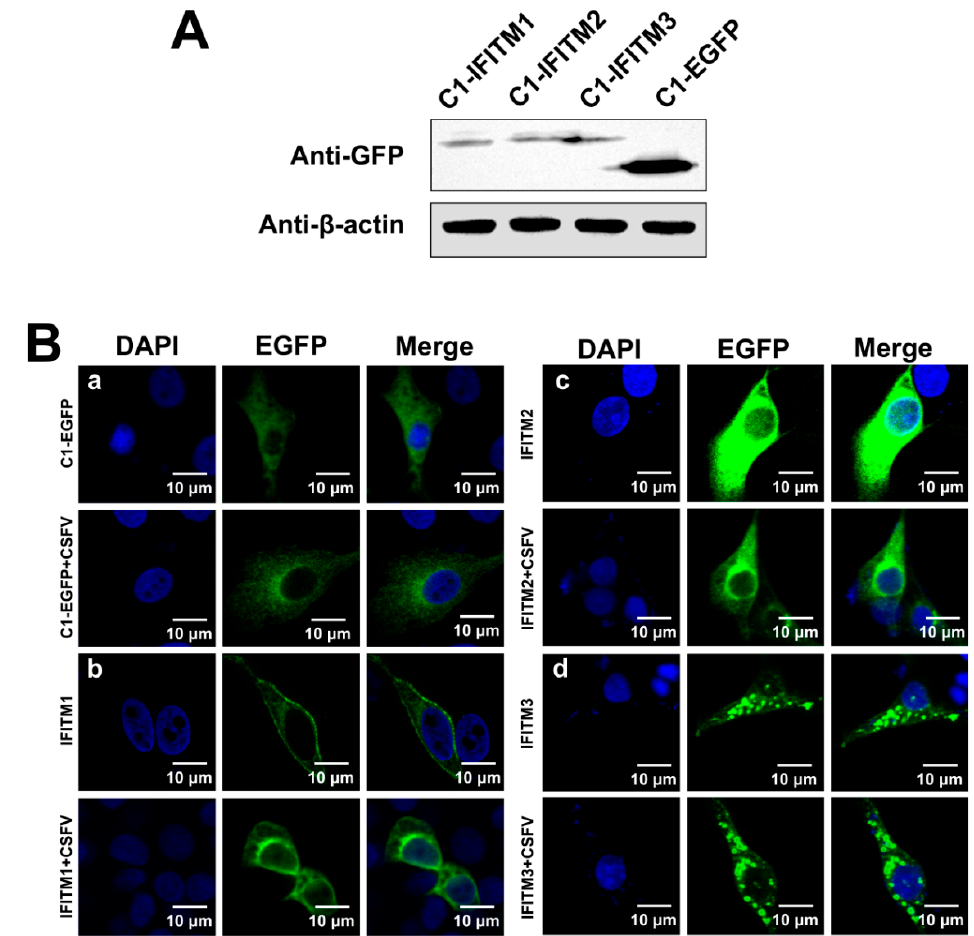
Figure 5. Distribution of IFITMs in CSFV-infected PAMs. ( A ) Confirmation of C1-IFITM1, C1-IFITM2, and C1-IFITM3 transfection in PAMs by western blot detection of fusion proteins with an anti-GFP antibody. PAMs were transfected with C1-IFITM1, C1-IFITM2, C1-IFITM3, or C1-EGFP for 48 h and collected for western blot analysis. β -actin served as an internal control. ( B ) Confocal images of PAMs expressing EGFP-tagged IFITM1, 2, or 3 or EGFP alone. PAMs were transfected with C1-EGFP ( a ), C1-IFITM1 ( b ), C1-IFITM2 ( c ), or C1-IFITM3 ( d ) for 24 h, followed by mock infection or infection with CSFV (MOI = 1) for another 24 h. Cells were fixed and stained with 4 (cid:48) ,6-diamidino-2-phenylindole (DAPI, blue). Scale bars, 10 µ